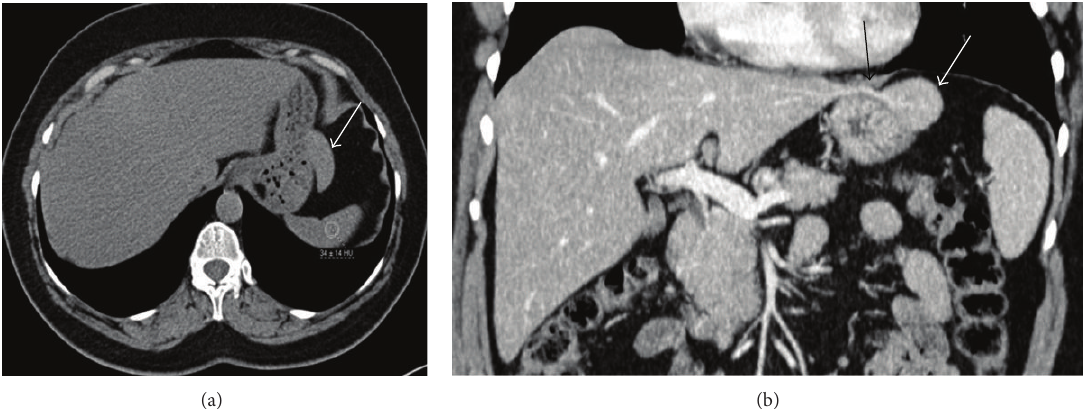
Figure 13: Nonenhanced axial CT image (a) of a 48-year-old female patient reveals a soft tissue mass (arrow) nearby greater curvature of the stomach. On coronal reformatted contrast enhanced CT image, there is a stalk (black arrow) between left lobe of the liver and the mass (white arrow) indicating accessory liver.